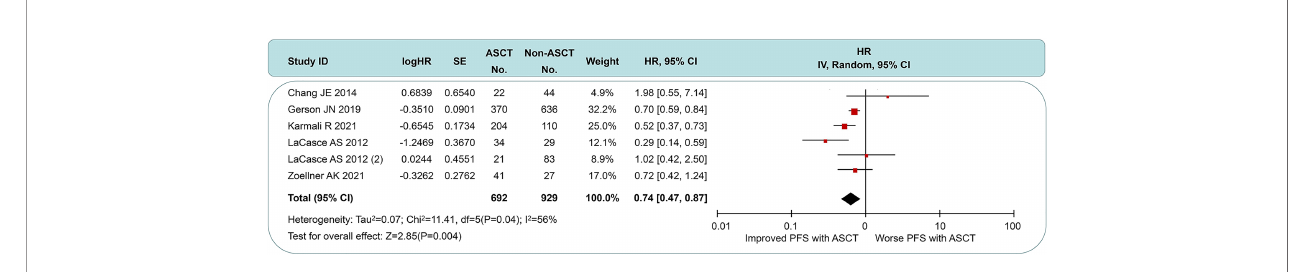
FIGURE 3 | Forest plot and meta-analysis of progression-free survival between ASCT and non-ASCT group in MCL patients. ASCT, autologous stem cell transplantation; MCL, mantle